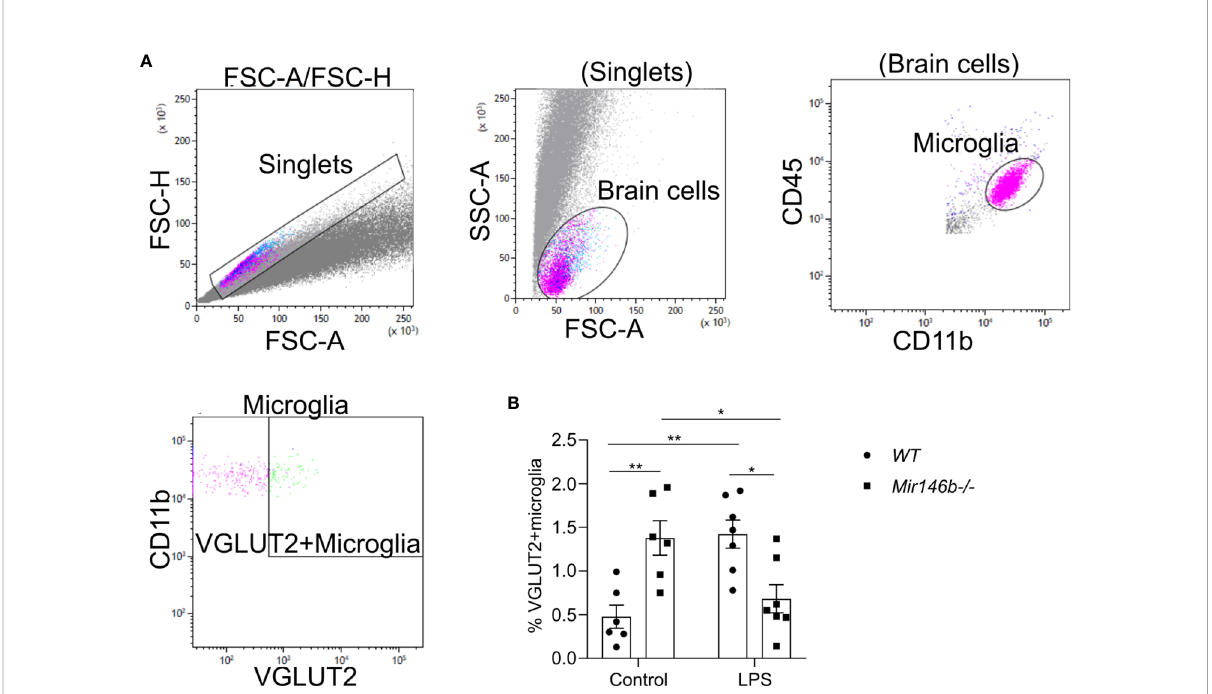
FIGURE 6 Phagocytic activity of hippocampal microglia in LPS-treated WT and Mir146b-/- mice. (A) Gating strategy for VGLUT2+ microglia among CD11b+CD45intermediate microglial cells. (B) Percentage of VGLUT2+ microglial cells upon LPS challenge in WT and Mir146b-/- mice. Number of animals = 6-7. Data represented as mean ± SEM; * p < 0.05, ** p < 0.01 (Two-way ANOVA with Tukey ’ s multiple comparisons